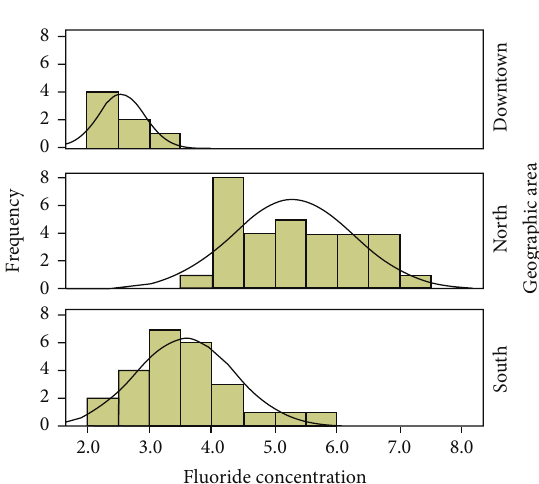
Figure5:Fluorideconcentrationfrequencydistributioninthethree regions of the city of